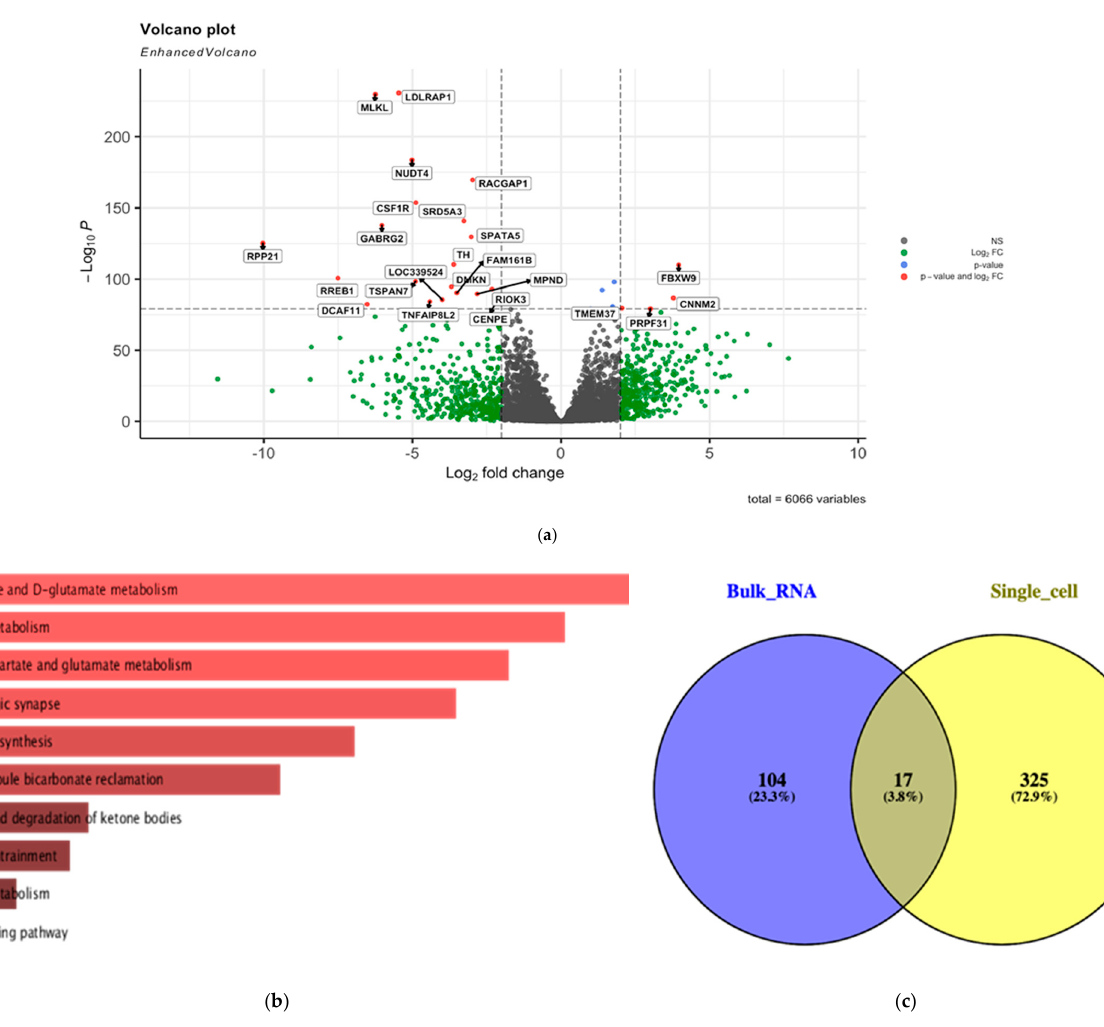
Figure 4. ( a ) Volcano plot for 6066 genes selected after preprocessing with p adjusted cut-off 10e-100 shown. Significantly up- or downregulated genes are shown in red; ( b ) enrichment analysis of the 76 genes participating in pathways that are presented in barplot. ( c ) Venn diagram representation of the common genes between bulk RNAseq analysis and single-cell analysis. In total 17 genes were found common between the RNA and single cell datasets.